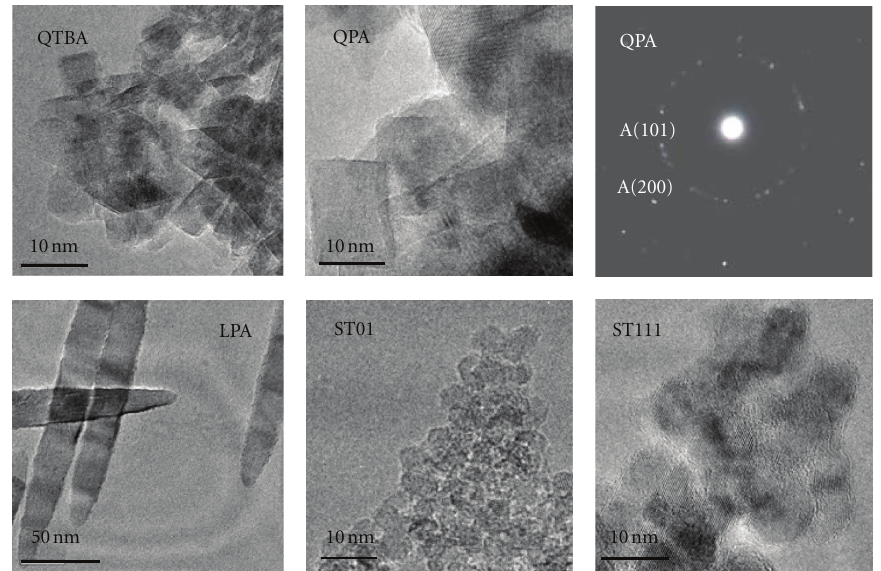
Figure 2: TEM images of the self-prepared (QTBA, QPA, and LPA) and the commercial (ST01 and ST111) TiO 2 nanocrystal samples and the SAED patterns of QPA sample. Table 1: Morphology and surface area of the TiO 2 nanocrystals and the optical data of the N719 dye adsorbed onto TiO 2 nanocrystals films. Sample